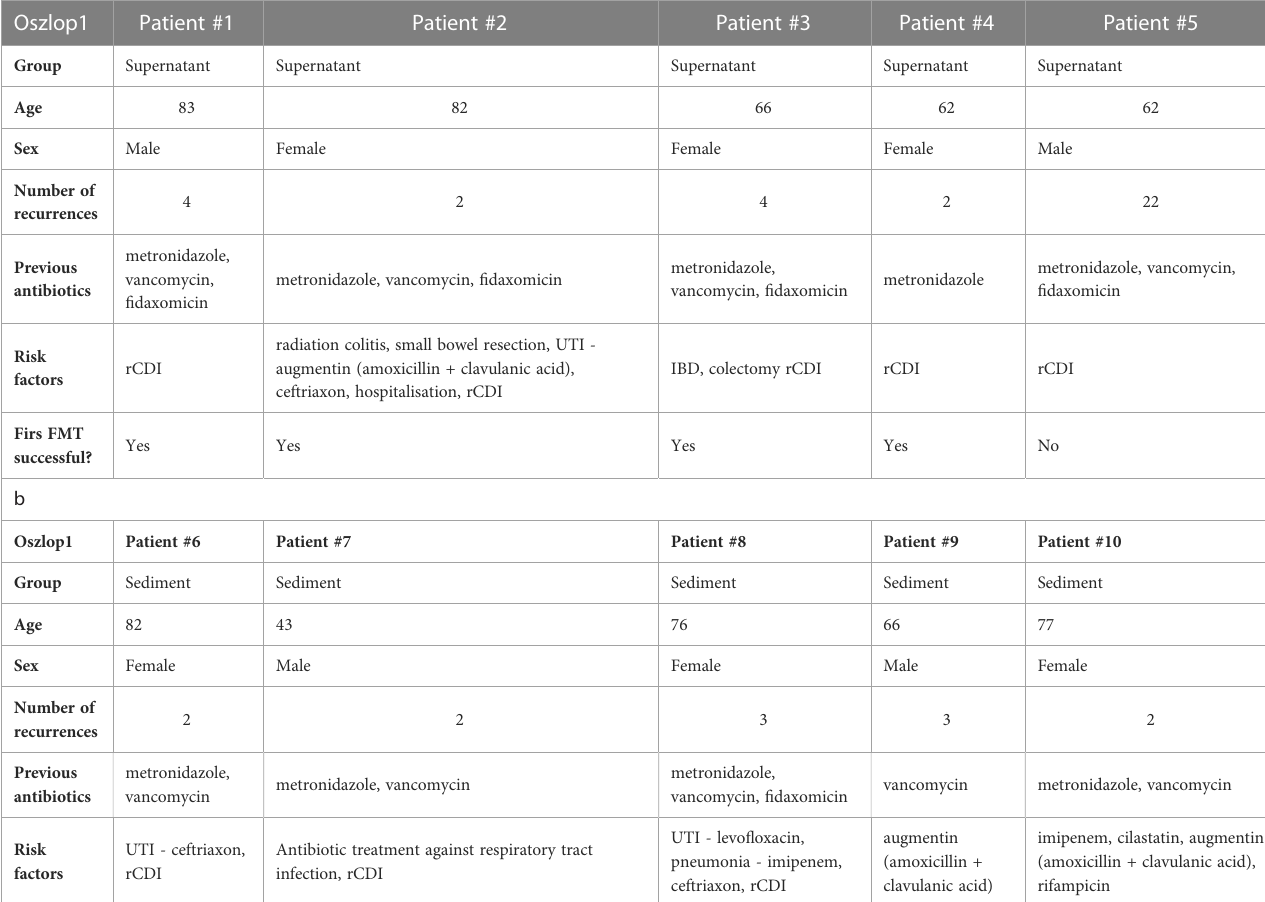
TABLE 3 Basic characteristics of FMT patients – supernatant (a) and sediment (b)